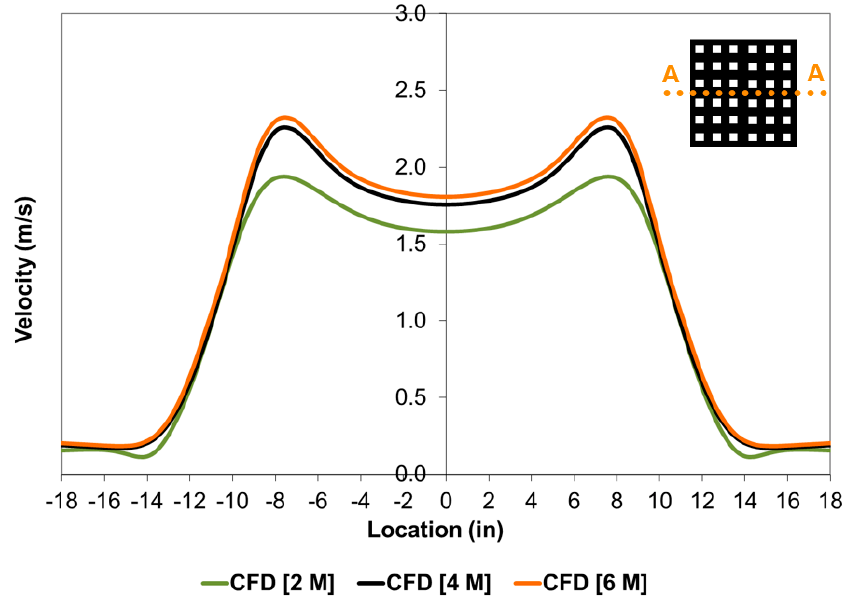
Figure 5. Grid independence study for velocity profiles at 1 ft height along line A ‐ A.